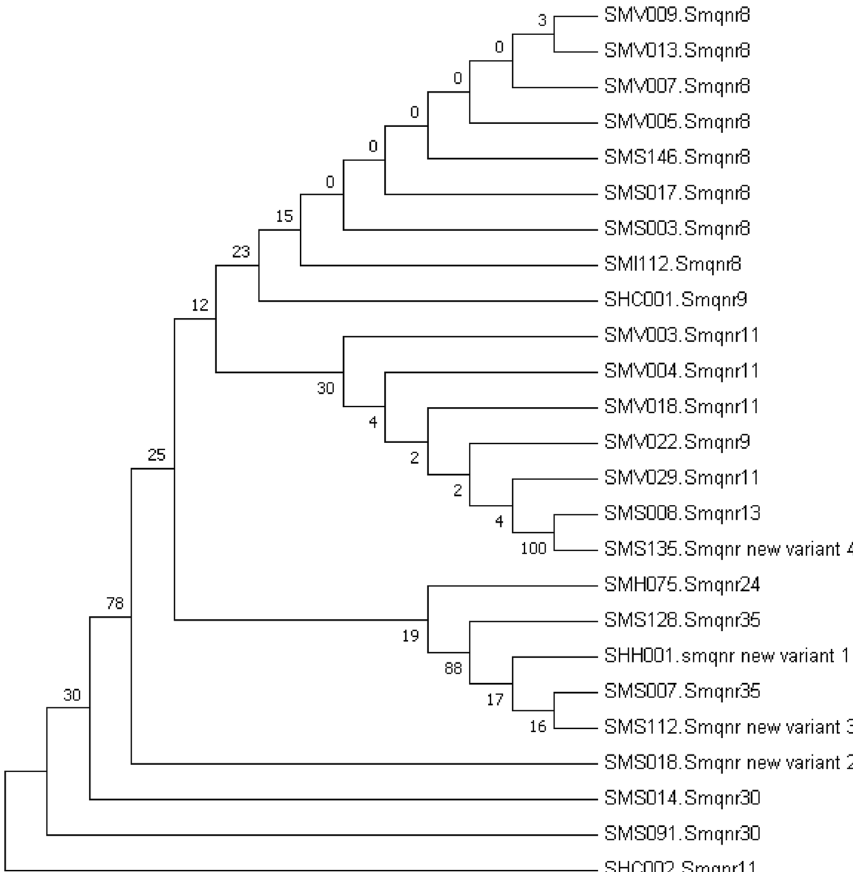
Figure 3. Phylogenetic tree of 4 new and already known Sm qnr alleles in Stenotrophomonas maltophilia strains tested in this study. The evolutionary history was inferred using the Neighbor-Joining method. The optimal tree with the sum of branch length = 3.10403504 is shown. The percentage of replicate trees in which the associated taxa clustered together in the bootstrap test (1000 replicates) are shown next to the branches. The evolutionary distances were computed using the Poisson correction method and are in the units of the number of amino acid substitutions per